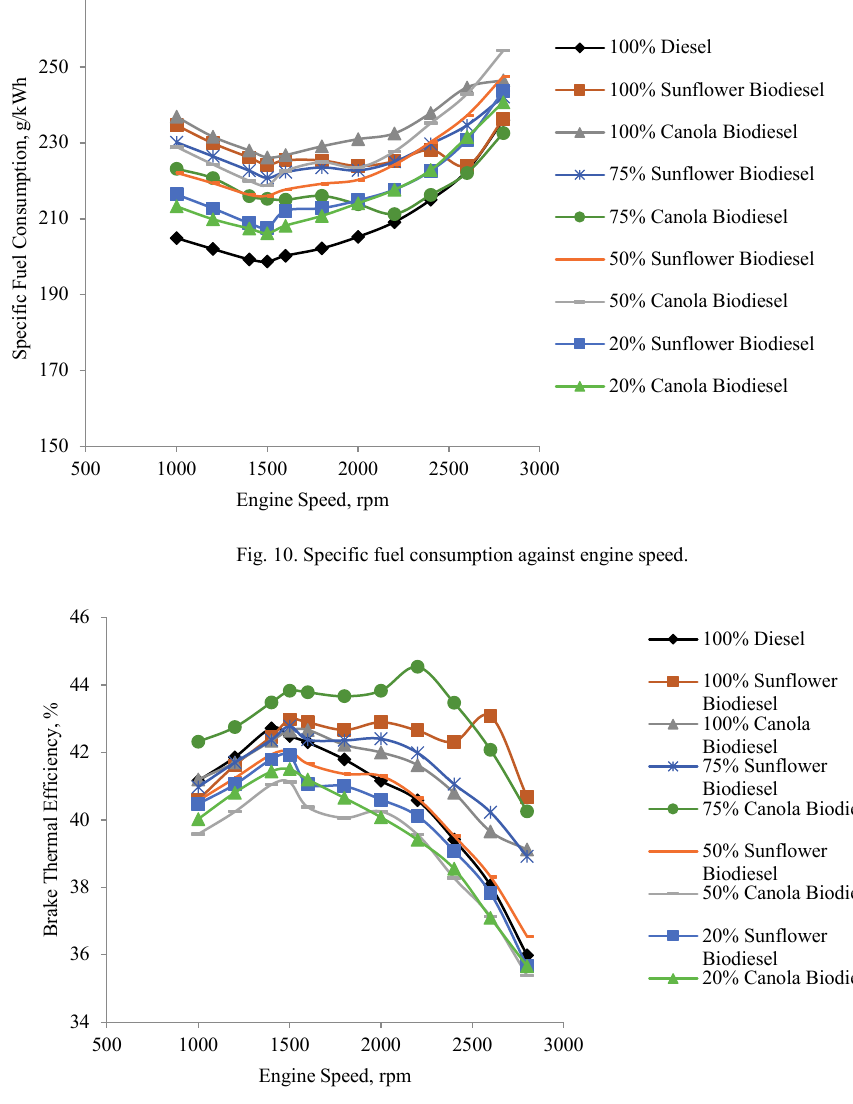
Fig. 11. Brake thermal efficiency against engine